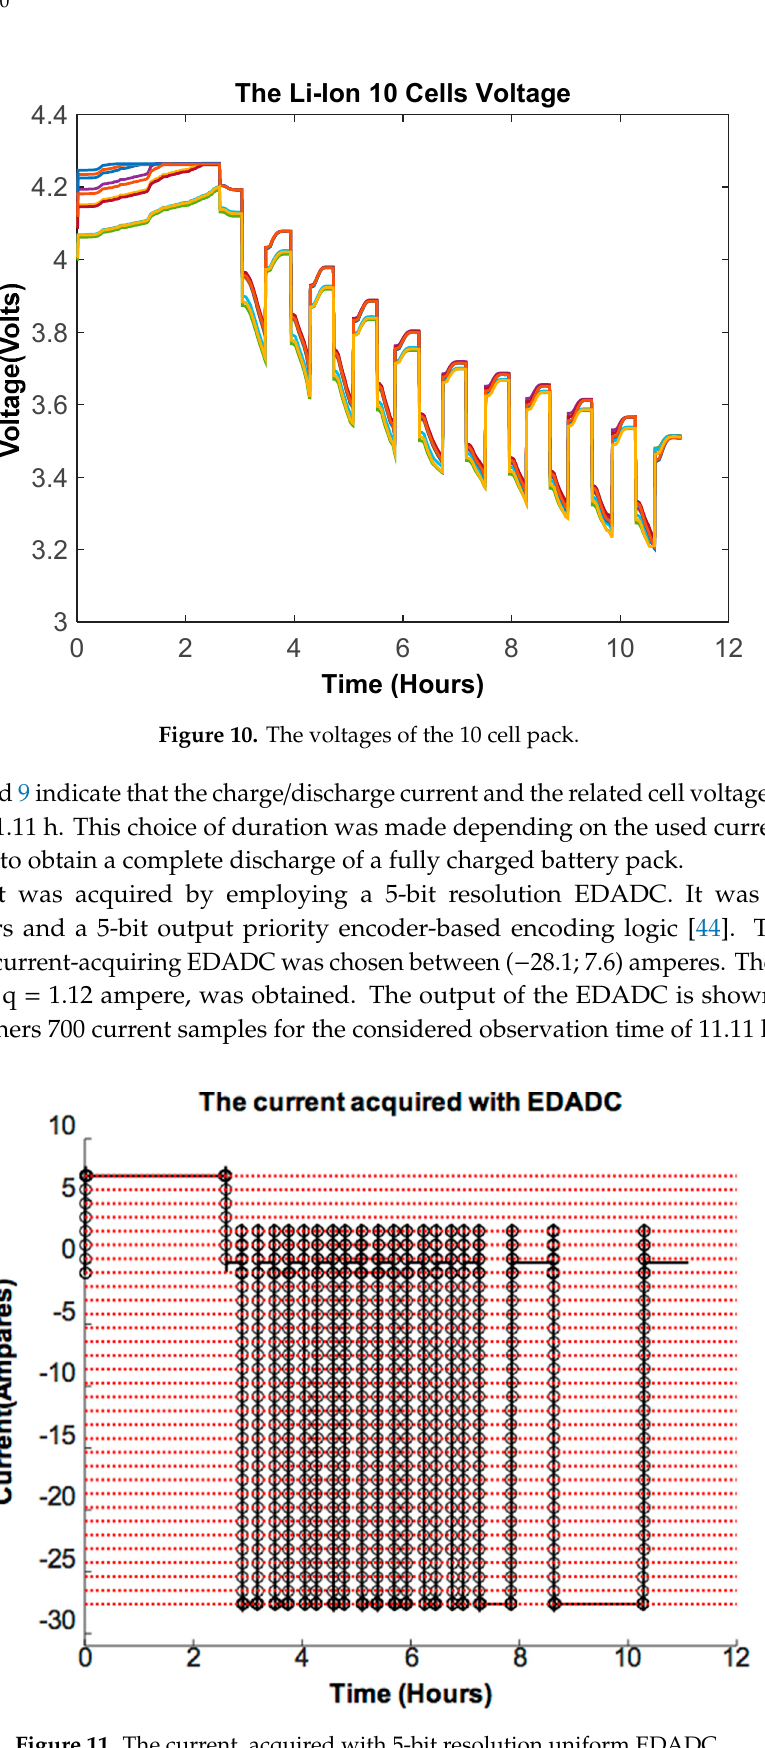
12 of 20 Figure 9. The battery pack voltage.